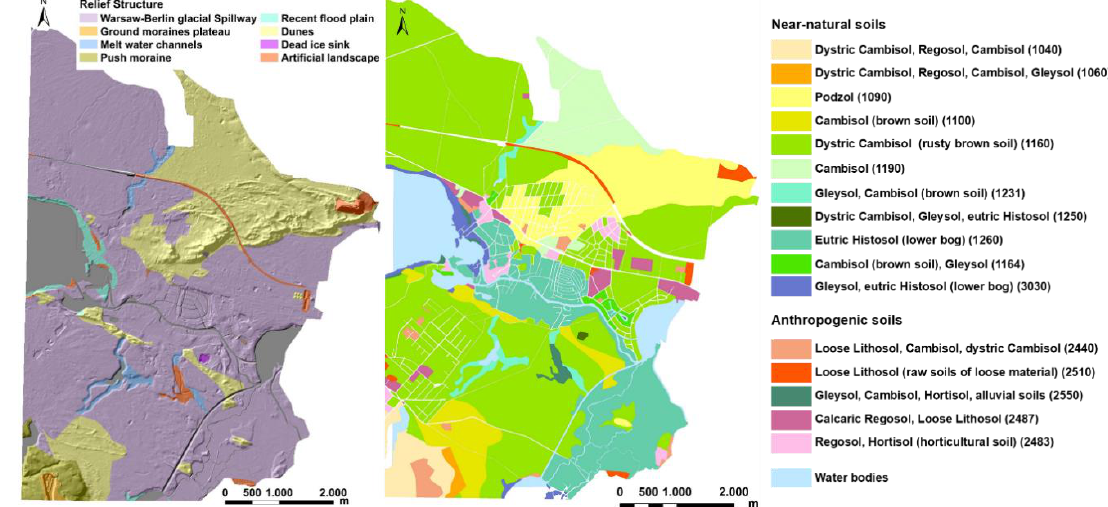
Figure 2. Relief structure of the study area ( left ) and soil types map ( right ). The soil associations and soil types are arranged according to their ID in the concept map with a scale of 1:50,000 for the whole territory of Berlin, which is subdivided into near-natural soils and anthropogenic soils according to the degree of anthropogenic influence and the change of soils [57].